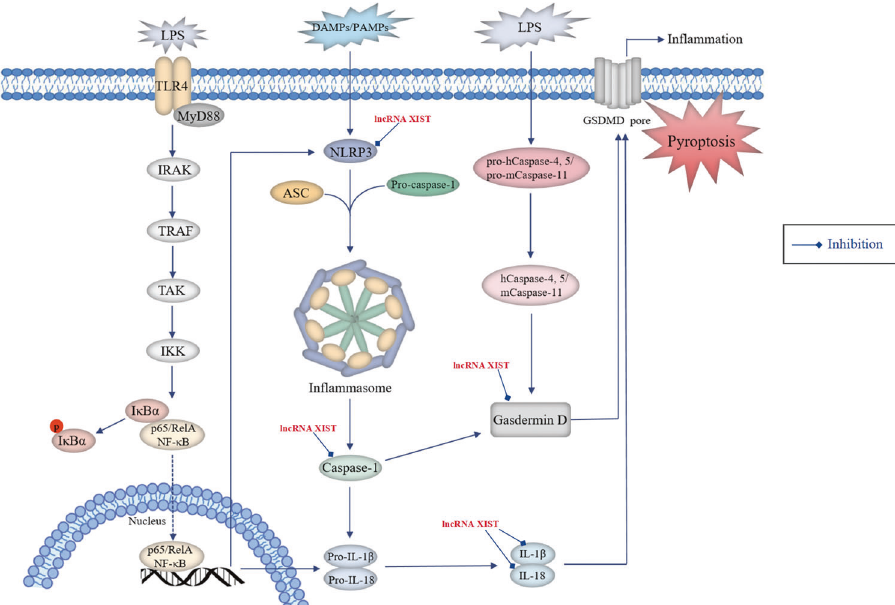
Fig. 4 Roles of lncRNAs in the regulation of pyroptosis in NSCLC. Pyroptosis can be induced via the caspase-1-dependent canonical pathway and caspase-4,5 (for human)- or caspase-11 (for mouse)-mediated non-canonical pathway. In terms of the canonical pathway, damage-associated molecular patterns (DAMPs) or pathogen-associated molecular patterns (PAMPs) activate the in fl ammasome sensors NLRP3, which then recruit the effector pro-caspase-1 with the aid of the adaptor protein ASC to assemble in fl ammasomes, leading to the conversion of pro-caspase-1 into active caspase-1. Activation of NLRP3 in fl ammasome requires the involvement of the TLR4-mediated NF- κ B pathway, which promotes the expression of NLRP3, pro-caspase-1, pro-IL-1 β and pro-IL-18 proteins. Activated caspase-1 cleaves gasdermin D (GSDMD) and ultimately mediates pyroptosis. Besides, caspase-1 promotes the maturation of pro-in fl ammatory cytokines IL-1 β and IL-18 by cleaving their precursor proteins, which trigger wide-ranging in fl ammatory responses. In the non-canonical pathway, human caspase-4 and -5 or their murine homologue caspase-11 can be directly activated by binding to lipopolysaccharide (LPS) and cleave GSDMD with ef fi ciency similar to that of caspase-1, thereby inducing cell pyroptosis. Oncogenic lncRNAs (red font, high expression in NSCLC) participate in lung cancer-associated pyroptosis by regulating pyroptosis-related